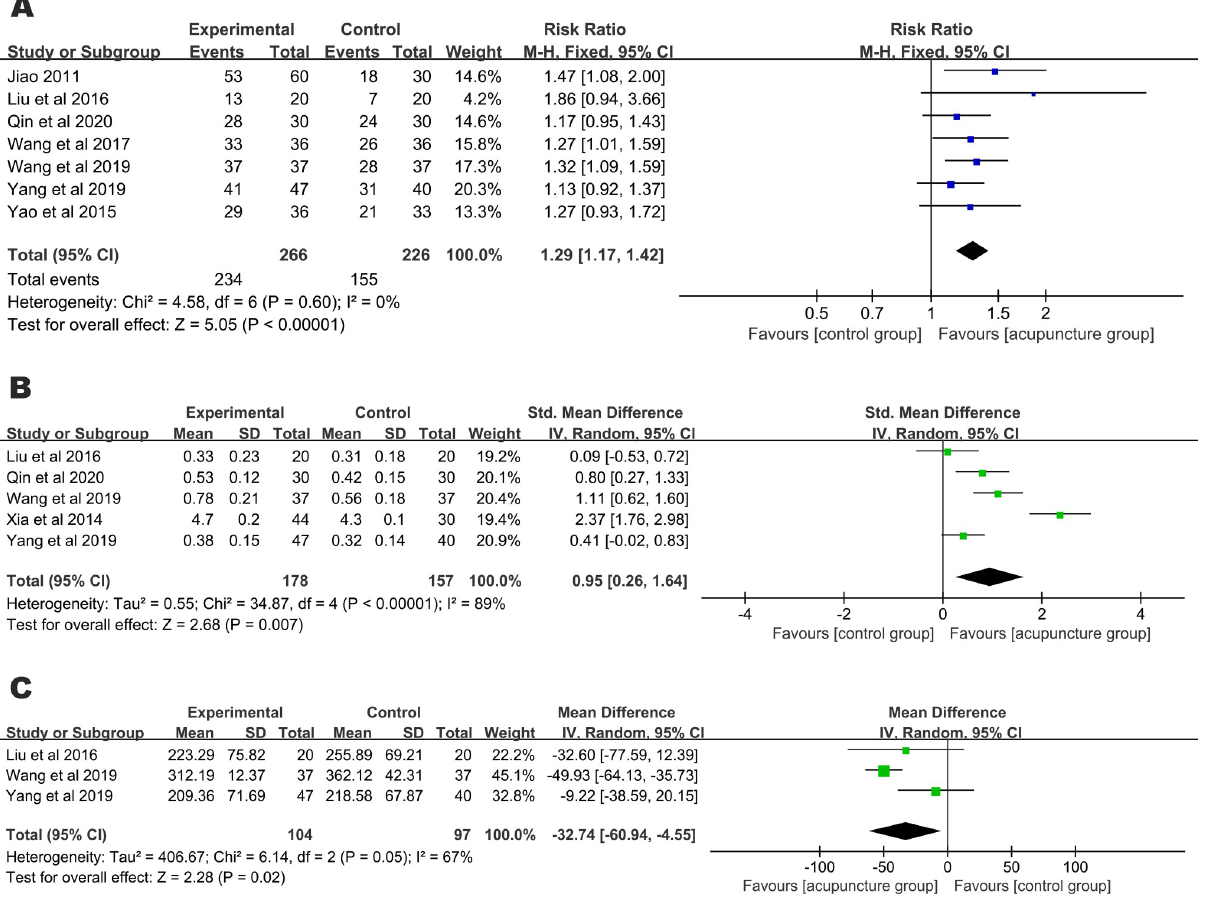
Fig 3. Forest plot of meta-analysis results. (A) Clinical response rates; (B) BCVA; (C) CMT.